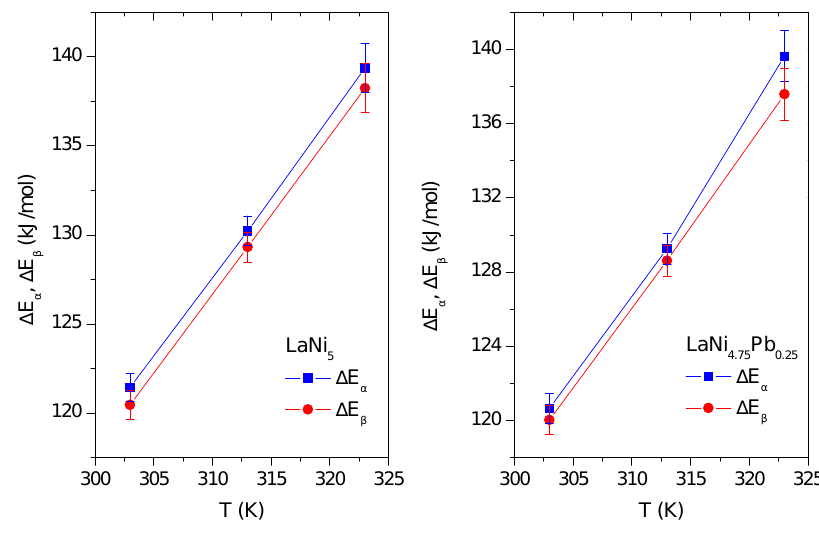
Figure 6. The absorption energies ∆ E α and ∆ E β versus temperature. Table 4. Values of the absorption energies ∆ E α and ∆ E β for both investigated alloys versus the process temperature. Alloy Temp (K) ∆ E α (kJ/mol) ∆ E β (kJ/mol) 303 121.4 120.4 LaNi 5 313 130.2 129.3 323 139.5 138.2 303 120.0 120.4 LaNi 4.75 Pb 0.25 313 129.3 128.9 323 138.7